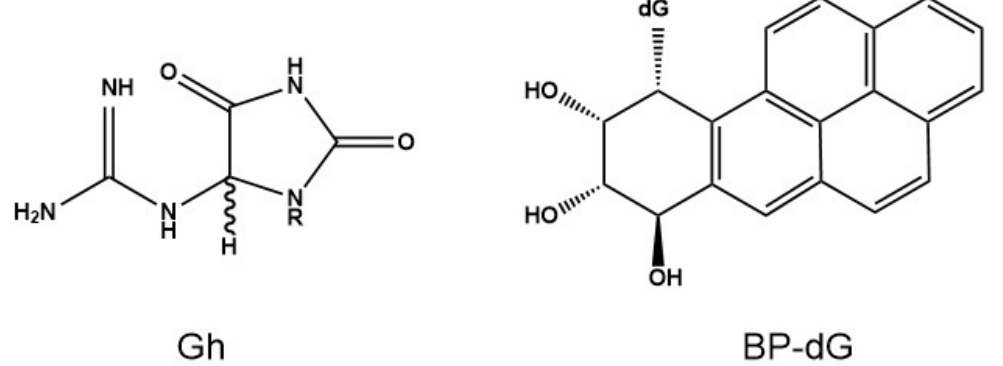
Figure 1. Structure of the guanidinohydantoin DNA lesion and benzo[ a ]pyrene diol epoxide ‐ de ‐ rived BP ‐ dG adduct ((+) ‐ cis ‐ stereochemistry, covalently attached to the exocyclic amino group of